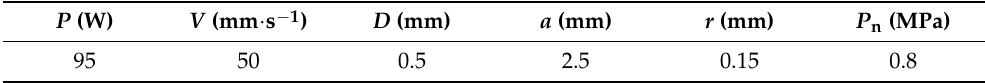
Table 3. CFRTS-TC4 laser high-speed rotational welding parameters.